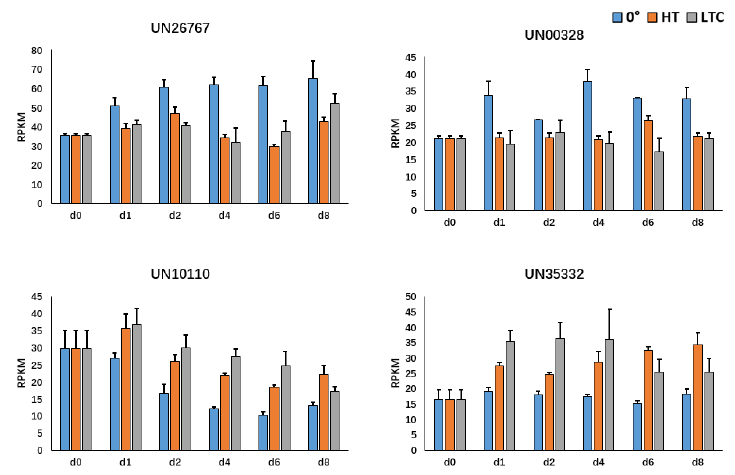
Figure 6. The RPKM of UN26767, UN00328, WRKY (UN10110) and BHLH (UN35332) at each time point under LTC, HT and 0 °C treatments from the RNA-Seq analysis of loquat